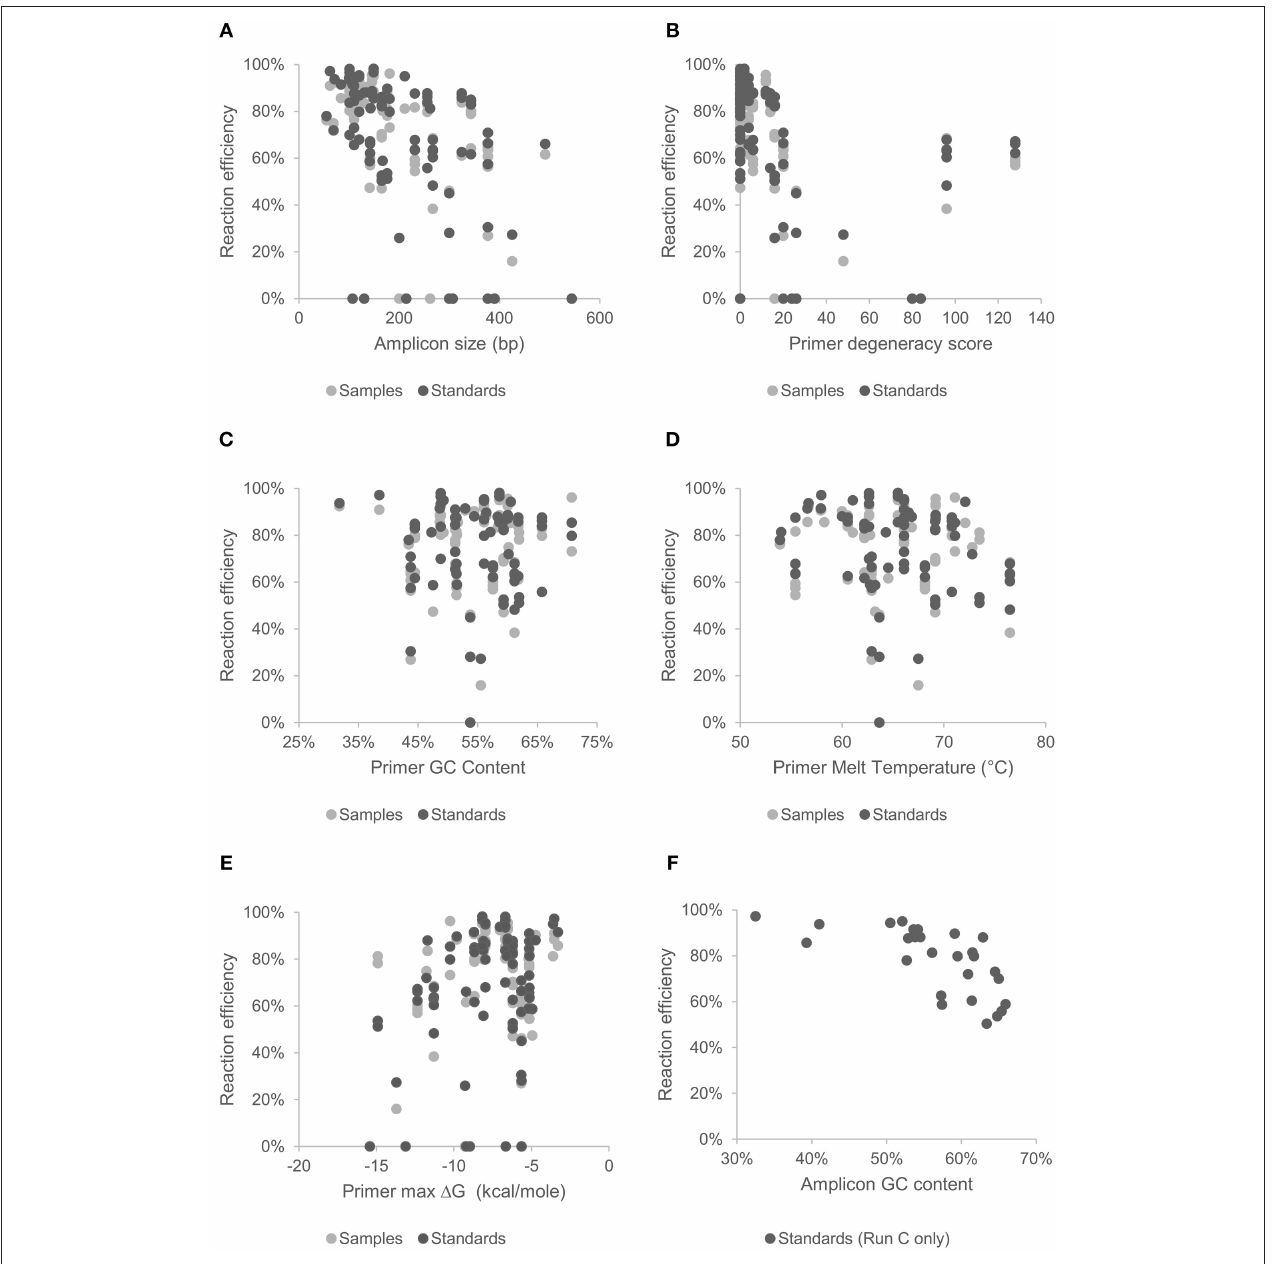
FIGURE 2 | Effect of amplicon size (A) , and primer characteristics; degeneracy (B) , GC content (C) , melt temperature (D) , and hetero-dimer 1 G (E) , on mean reaction efficiency of samples and standards across all chips and assays. Effect of GC content of gBlock artificially synthesized standards (Set C) on reaction efficiency are shown in (F)